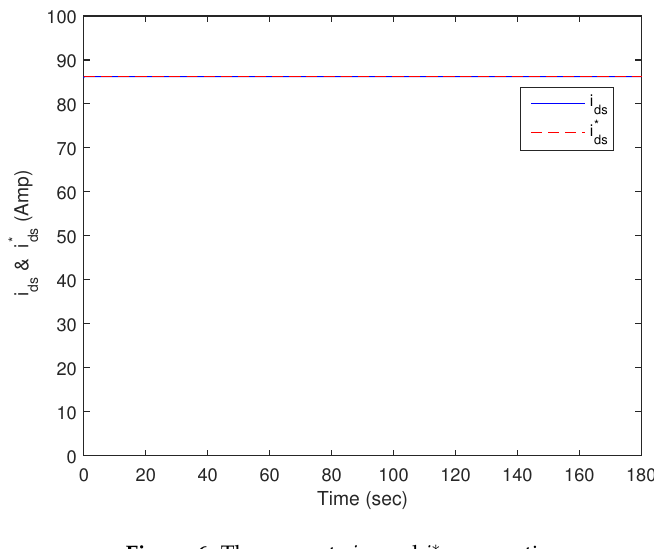
Figure 6. The currents i ds and i ∗